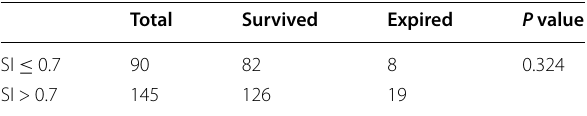
Table 2 SI on admission with statistical significance in predicting outcome